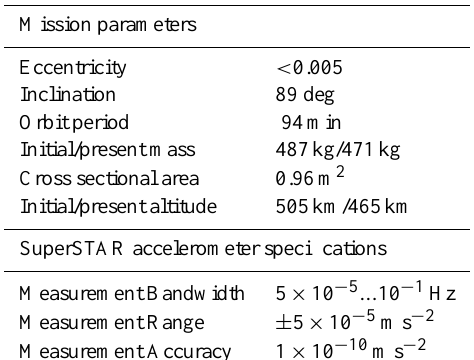
Table 2. GRACE mission parameters and accelerometer specifica- tion. The satellite mass and mean altitude are given for the mission start in 2002 and the present time (1 January